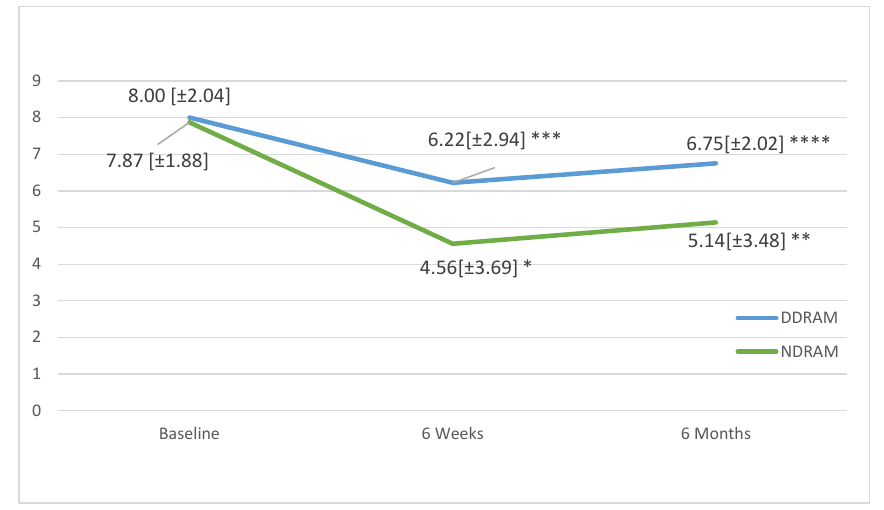
Figure 1. Change in low back pain as measured on a visual analogue scale in each study group throughout the follow-up. Scores expressed as means and standard deviations. p -values calculated with paired Student’s t -test. * p < 0.001, ** p < 0.005, *** Not Significant, **** Not